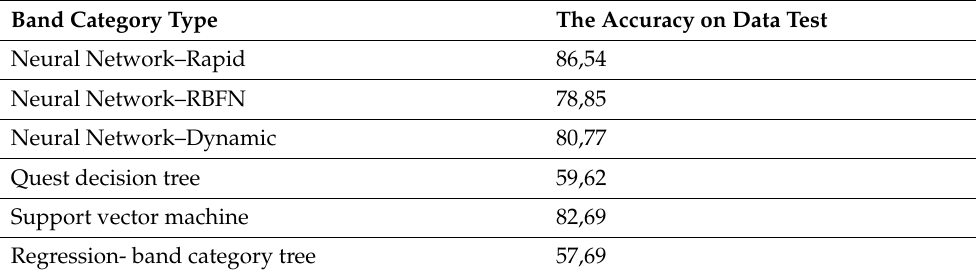
Table 3. Evaluation of obtained clusters for traffic data.